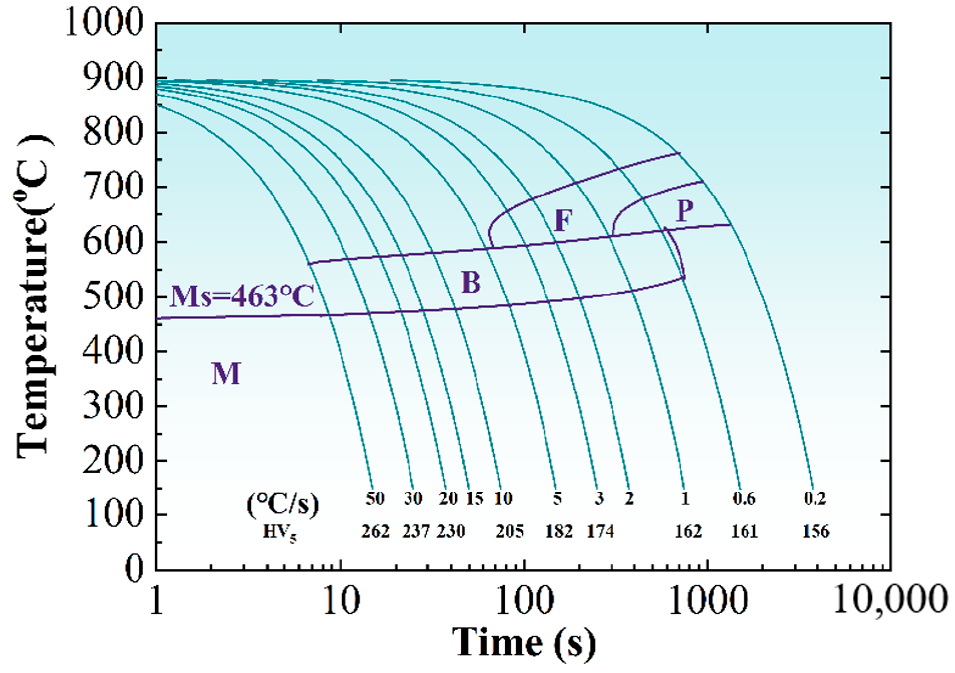
Figure 13. Thermal process of incomplete recrystallized UACG-HAZ and the thermal simulation microstructures (with a magnification of 500): ( a ) thermal cycles; ( b ) microstructures of the thermal simulation zone.